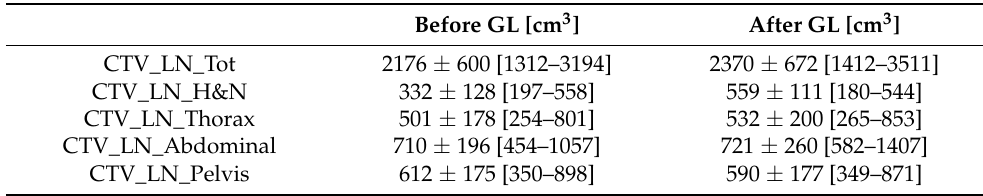
Table 3. CTV_LN and lymph node substructure volume analysis, before and after the guidelines’ introduction; the minimum and maximum values are reported in parentheses.